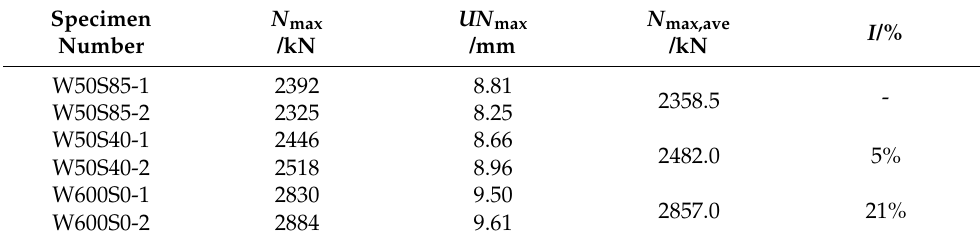
Table 4. Load capacity of the specimens.